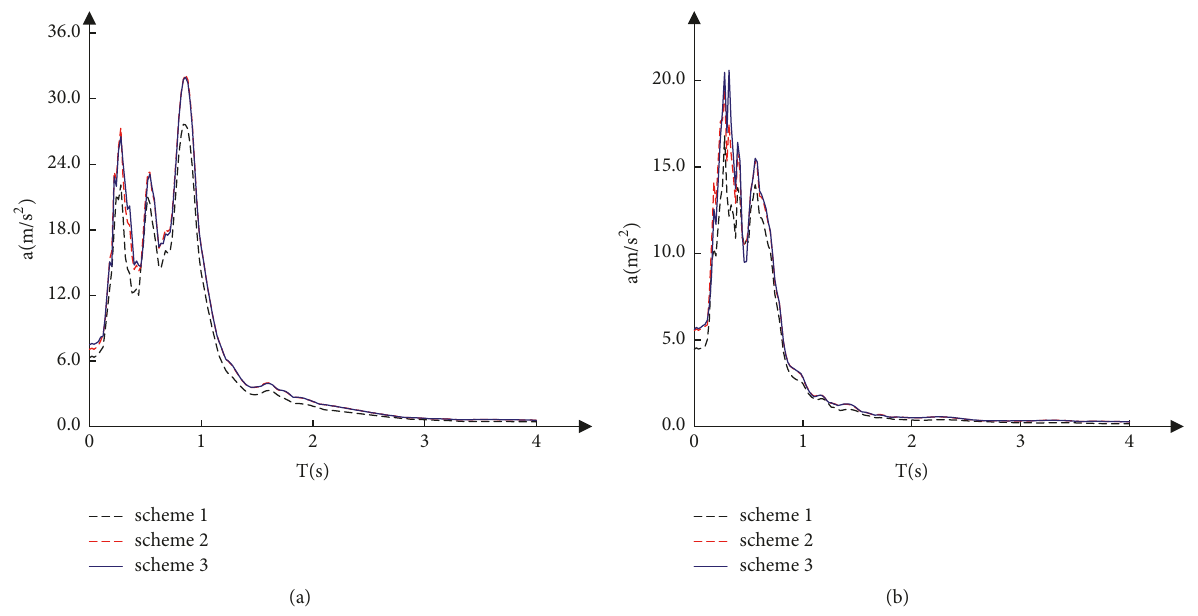
Figure 20: Acceleration spectrums of downstream dam crest: (a) horizontal and (b) vertical.